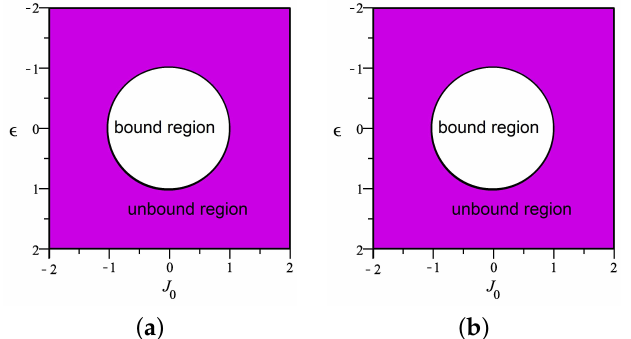
Figure 2. ( a ) In the space ( J 0 , (cid:101) ) and for fixed ω 2 Hamiltonian (1) form an open disc of radius ω 2 bounded Hamiltonian (1) in the space ( J 0 , ω 2